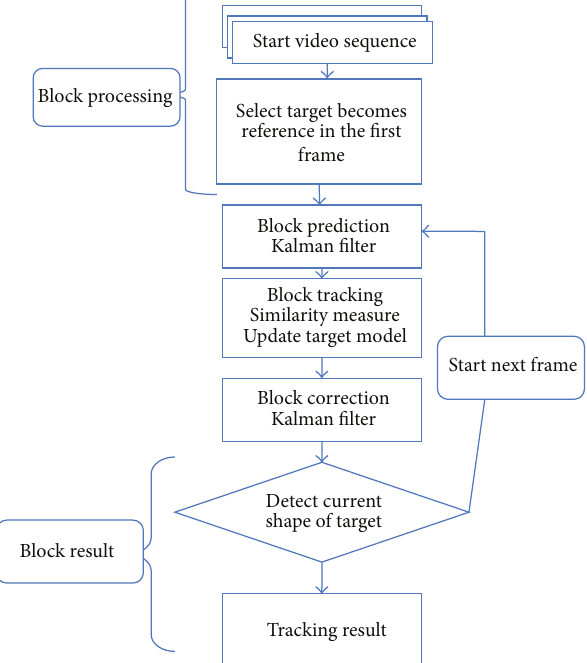
Figure 1: Flowchart for the proposed approach